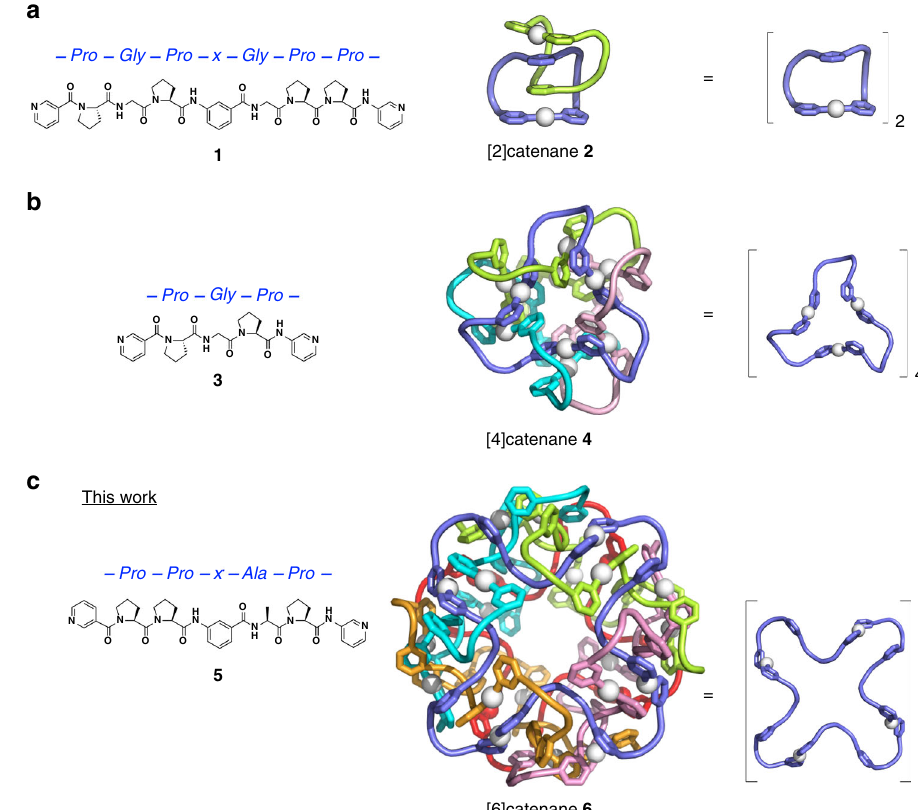
Fig. 1 Pyridine-tethered oligopeptide ligands and their self-assembled structures on coordination to Ag + . a Peptide ligand 1 with a PGPxGPP sequence (x: imino-(1,3-phenylene)carbonyl spacer) gives [2]catenane 2 , which is composed of two Ag 1 ( 1 ) 1 macrocycles (crossing number: 2). b Peptide ligand 3 with a PGP sequence forms [4]catenane 4 , which contains four Ag 3 ( 3 ) 3 macrocycles fully interlocked in tetrahedral manner (crossing number: 12). c Peptide ligand 5 with a PPxAP sequence affords [6]catenane 6 , which is composed of six Ag 4 ( 5 ) 4 macrocycles multiply interlocked in a cubic manner (crossing number: 24). The peptide regions are drawn as cartoon loops, and the pyridyl and m -phenylene parts in stick representation. Individual macrocycles linked by coordination to Ag + (white spheres) are